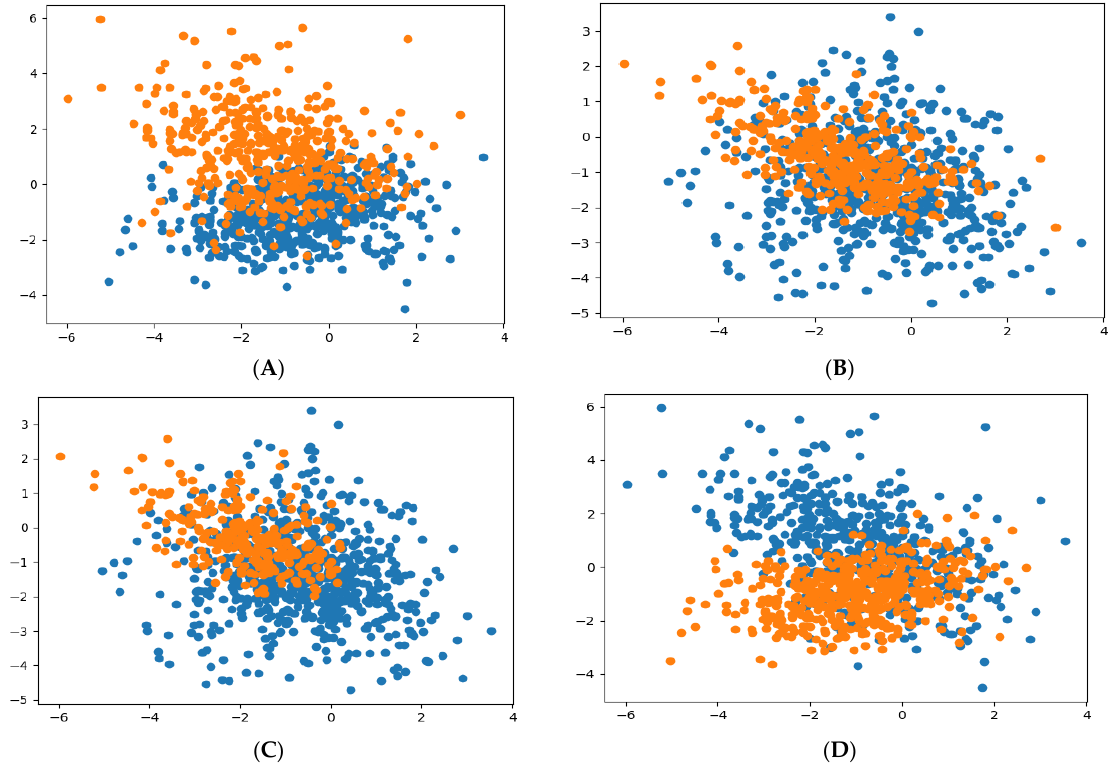
Figure 5. Simulated results for two clusters showing states of the sensor for the algorithms: mini- batch K-means clustering ( A ), spectral clustering ( B ), Gaussian mixture clustering ( C ), and birch clustering ( D ).